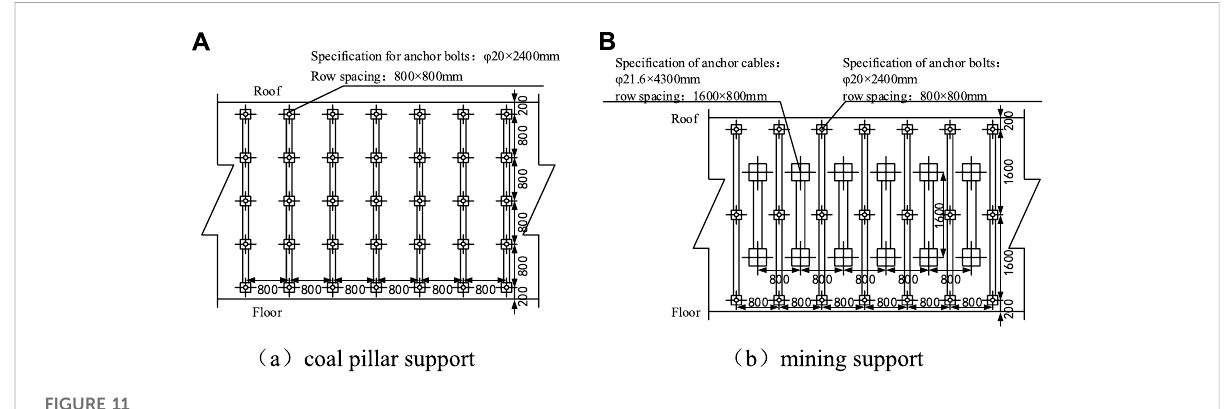
FIGURE 11 Two sides of roadway support. (A) Coal pillar-side support and (B) mining-side support.